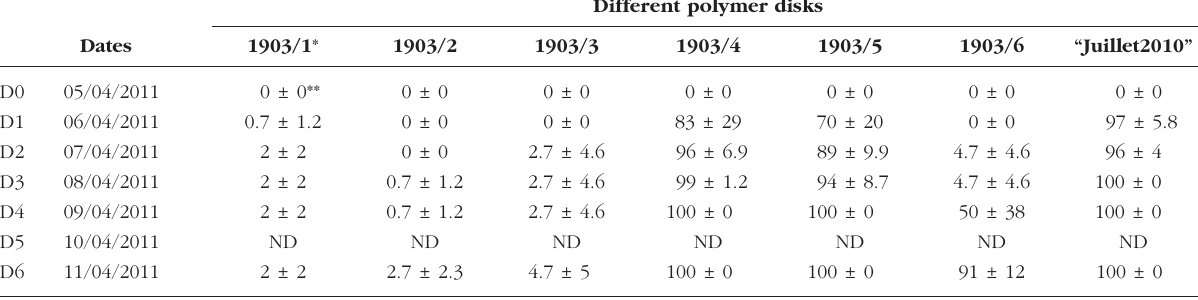
Table II. – Experiment A: larval reduction rates (%) of Ae. albopictus in presence of geraniol impregnated polymer disks.